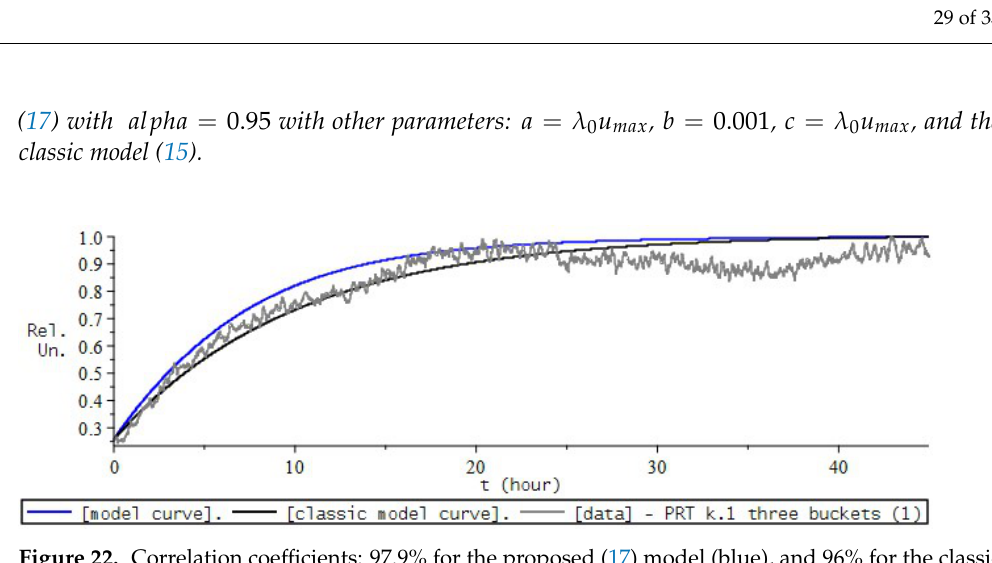
Figure 22. Correlation coefficients: 97.9% for the proposed (17) model (blue), and 96% for the classic (15) model (black).